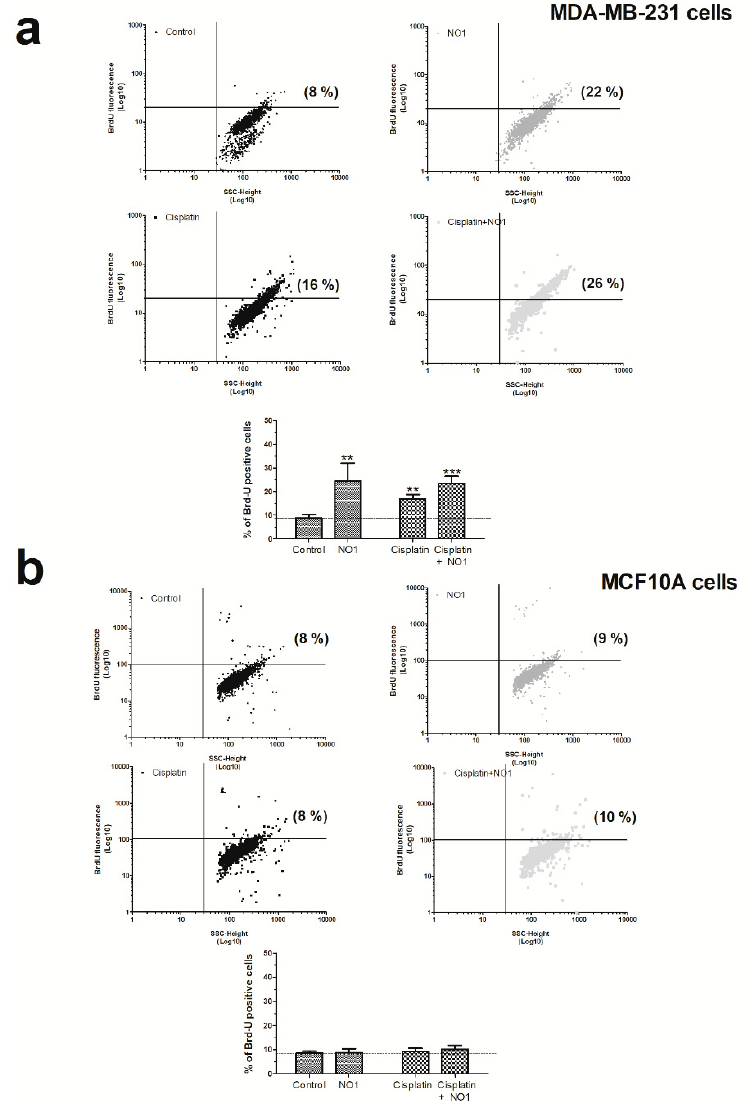
Figure 4. NO1 promotes apoptosis in MDA-MB-231 cells. MDA-MB-231 cells ( a ) and MCF10A ( b ) cells were treated with the σ 2R / TMEM97 ligand, NO1 (100 nM for 5 min) or the antineoplastic drug, cisplatin (50 µ M for 30 min) or a combination of both drugs. Once the incubation time with the drugs was over, the cells were fixed, and subsequently, BrdU-loading was achieved by following the instructions provided with the commercial apoptotic kit. The percentage of apoptotic cells was assessed using flow cytometry and the Flowing free software using the masks established for each of the cell populations. Dot-plots are representative of four different experiments, and histograms represent the mean ± standard error of the mean (S.E.M.) of the percentage of positive BrdU stained cells after treatment with NO1 with respect the values found in the control cells. ** and *** represent p < 0.01 and p < 0.001, respectively, compared to controls cells.